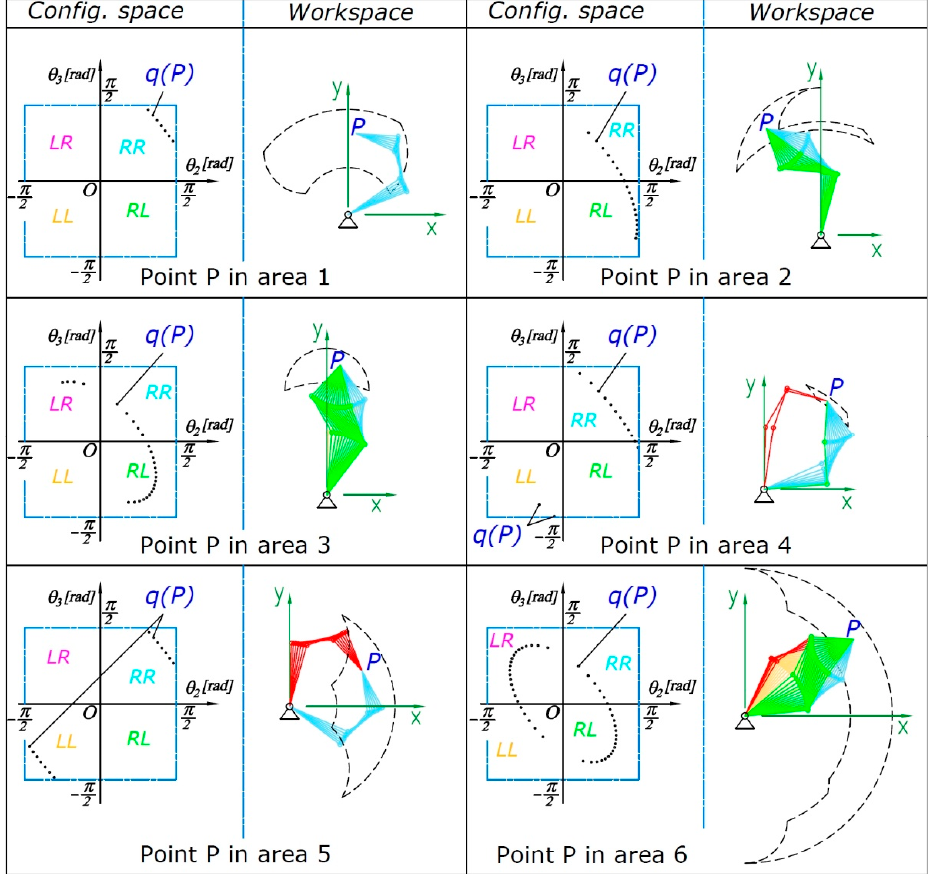
Figure 17. Mapping the robot’s workspace according to the type of solution.